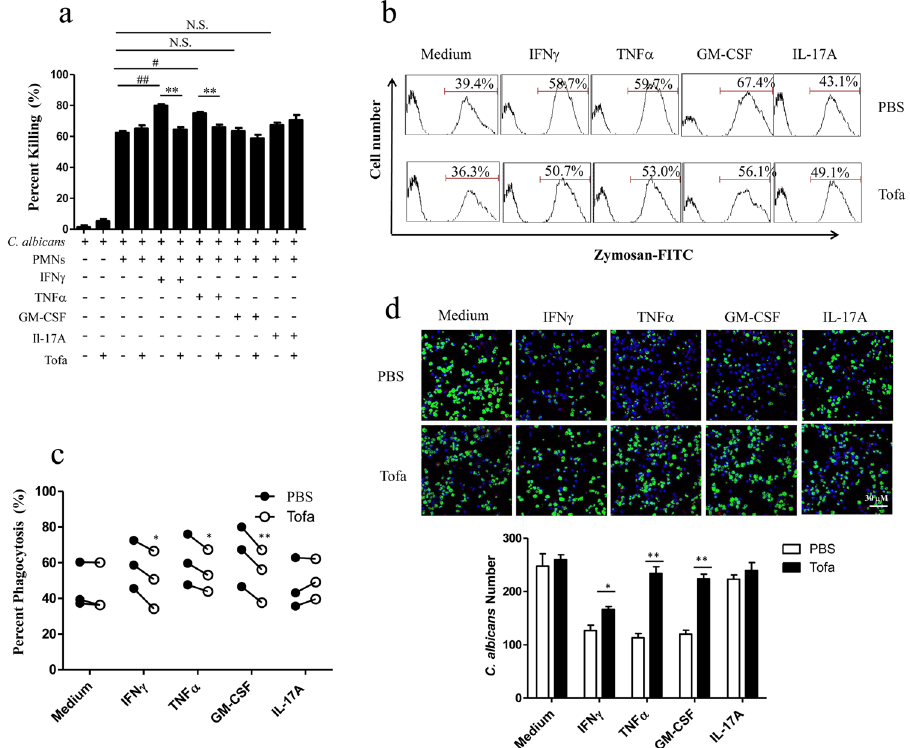
Figure 3. Inhibitory effect of tofacitinib on the candidacidal activity of human PMNs. Freshly isolated human PMNs were pre-treated, in triplicate wells, with IFN γ (10 ng/ml), TNF α (200 U/ml), GM-CSF (10 ng/ml) or IL-17A (10 ng/ml) in the presence, or absence, of tofacitinib (1 μ M). Viable C. albicans cells were then added to the cultures for fungal killing assays, with C. albicans cultured alone as total CFU control ( a ). The results are expressed as percent killing calculated as 100 × (total CFU-survived CFU)/total CFU. ## p < 0.001; # p < 0.05; ** p < 0.01. For phagocytosis analysis, cytokine-treated PMNs (with or without tofacitinib) were fed with zymosan-FITC for 30 minutes followed by FACS analysis. Representative results using blood samples from one donor are shown as histograms, fluorescence positive peaks (indicated by red bars) represent FITC-zymosan- containing cells ( b ). Repeating results using samples from 3 unrelated donors were individually converted into percent phagocytosis (fluorescence positive cells) for statistical comparison between groups treated with PBS (filled circle) or tofacitinib (open circle) ( c) . Each pair of filled and open circles represents data from one donor. * p < 0.05, ** p < 0.01. ( d ) For further visualization of the inhibitory effect of tofacitinib on fungal digestion by PMNs, human PMNs were treated as above, then incubated with FITC-labeled opsonized C. albicans for 4 h, followed by 4% PFA fixation and DAPI staining. Images were acquired by confocal microscopy and undigested C. albicans in each group were numerated for statistical comparison. The results are expressed as average number of C. albicans per scope. * p < 0.05, ** p <